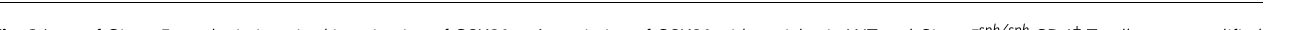
Fig. 3 Loss of Gimap5 results in impaired inactivation of GSK3 β . a Association of GSK3 β with vesicles in WT and Gimap5 sph/sph CD4 + T cells as exempli fi ed by GSK3 β intensity, vesicle number, and vesicle size of GSK3 β spots 6 and 24 h after α CD3/ α CD28 activation. b Bright detail similarity analysis (ImageStream) of activated CD4 + T cells from WT and Gimap5 sph/sph mice show colocalization between Gimap5 and GSK3 β . c Representative Z-stacks of WT and Gimap5 sph/sph CD4 + T cells stimulated for 24 h with α CD3/ α CD28. d Immunoblot analysis of WT and Gimap5 sph/sph CD4 + T cells stimulated with α CD3/ α CD28 depicting total and phosphorylated protein levels of GSK3 β (P-Ser9 and P-Ser389), p38, and p53. e – i Localization of total and phospho- GSK3 β (Ser389) in WT or Gimap5 sph/sph CD4 + T cells after 2 days stimulation with α CD3/ α CD28 ( n = 3). f Nuclear localization and h expression of total GSK3 β . g Nuclear localization and i expression of p-GSK3 β (Ser389). Hatched bars represent resting and solid bars represent CD3/CD28-activated CD4 + T cells. Graphs depict mean values ± SD. ImageStream data represent average values of > 500 CD4 + T cells per sample. All experiments were performed at least three times. Statistical signi fi cance is determined by Student ’ s two-tailed test. BF bright fi